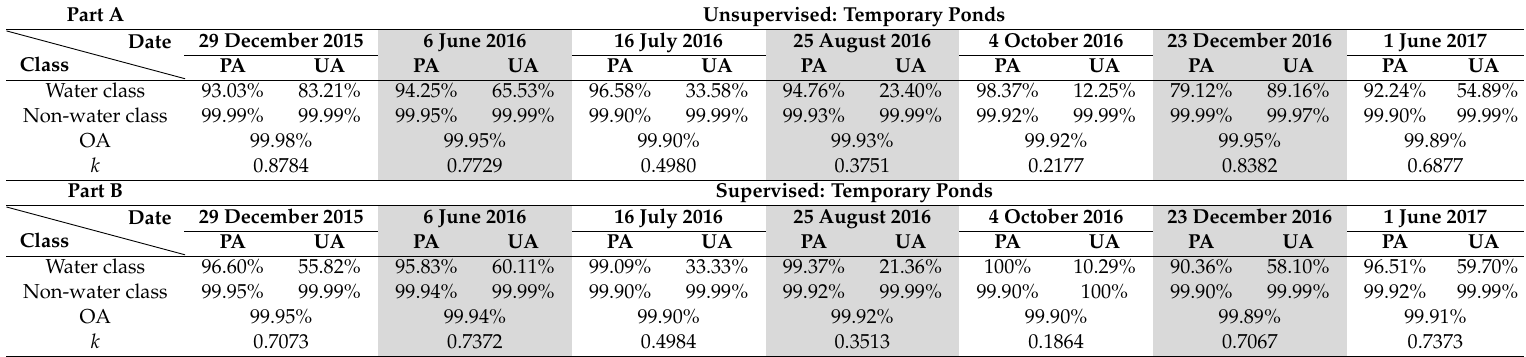
Table 7. Part A and Part B show for the temporary ponds the accuracy assessment results for the unsupervised and supervised approaches, respectively. Part